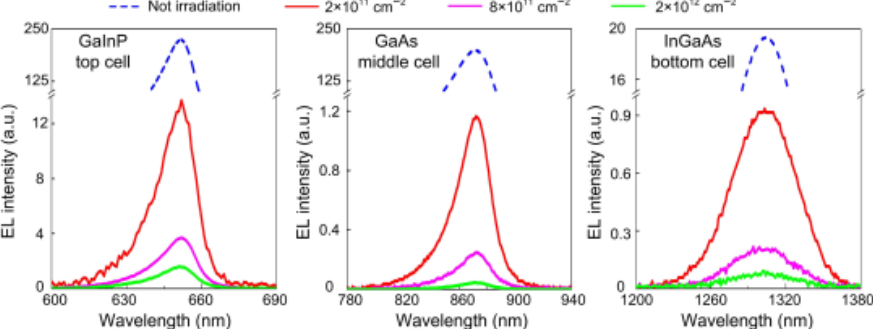
Figure 2. EL spectra of IMM3J solar cells irradiated with 2 MeV protons at fluence ranging from 0 to 2 × 10 12 ions/cm 2